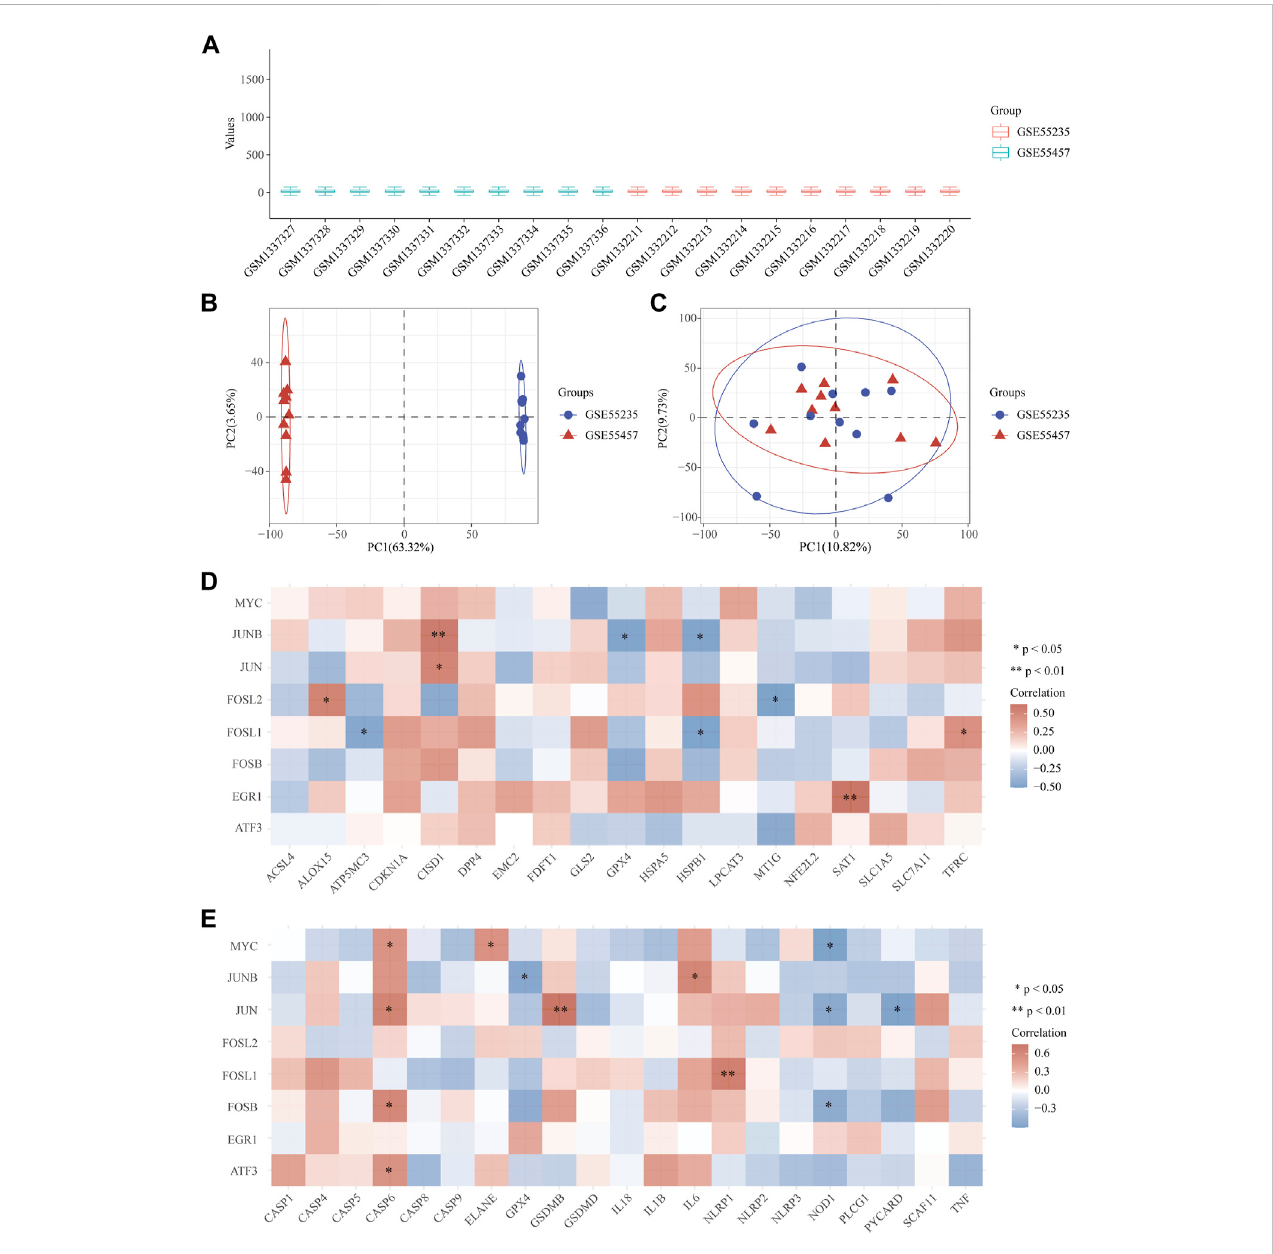
FIGURE 5 Correlation between OA hub genes and ferroptosis or pyroptosis related genes. (A) The data standardization evaluated by box diagram after the combinationand normalizationof2groups. (B, C) ThevisualPCA diagrambefore (B) andafter (C) removal ofthebatch. (D,E) The heatmap ofthecorrelation between hub genes and genes related to ferroptosis and pyroptosis. The horizontal and vertical coordinates represent genes. Different colors represent the correlation coef fi cient (red represents positive correlation, blue represents negative correlation). PC = Principal Component.